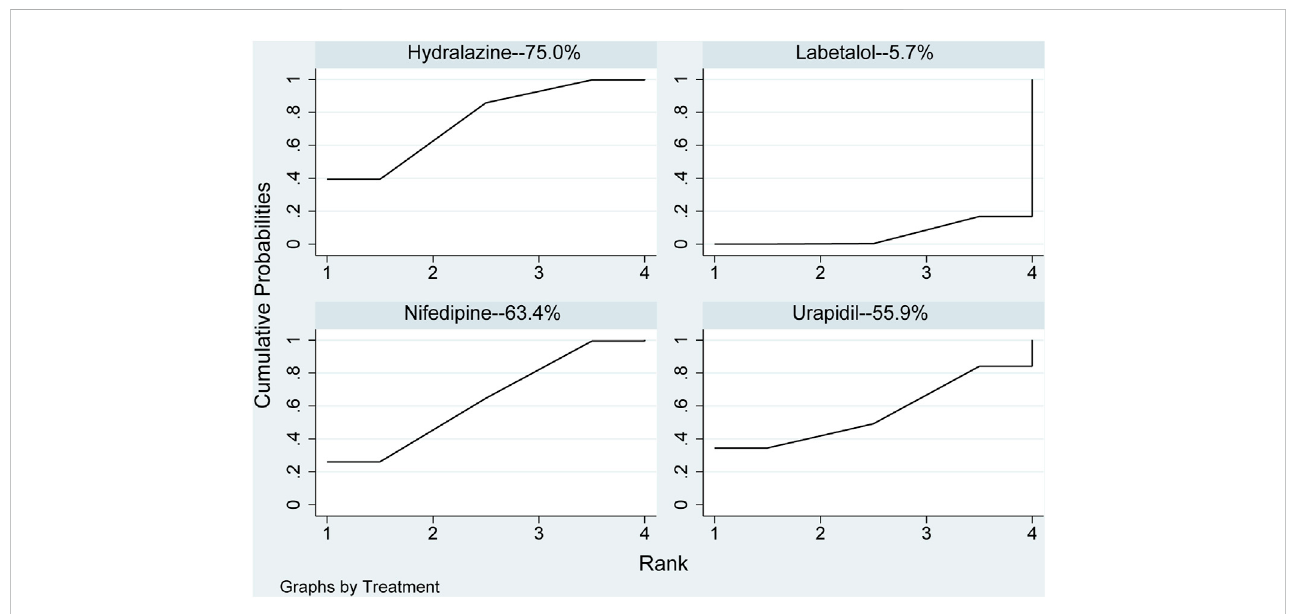
FIGURE 5 Ranking of all pharmaceuticals for the dosage required to reach the target blood pressure. Note: The larger the area under the curve, the more likely it is to be the best intervention. SUCRA, Surface under the cumulative ranking.